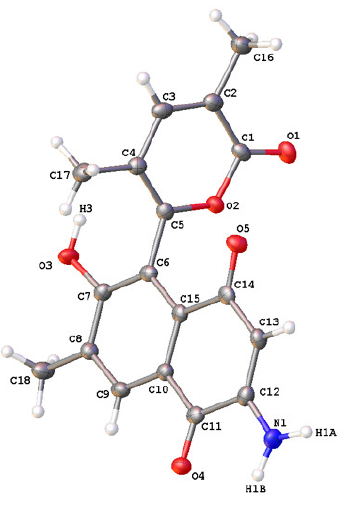
Figure 3. Selected COSY60 and HMBC correlations observed for salinisporamine ( 5 ).